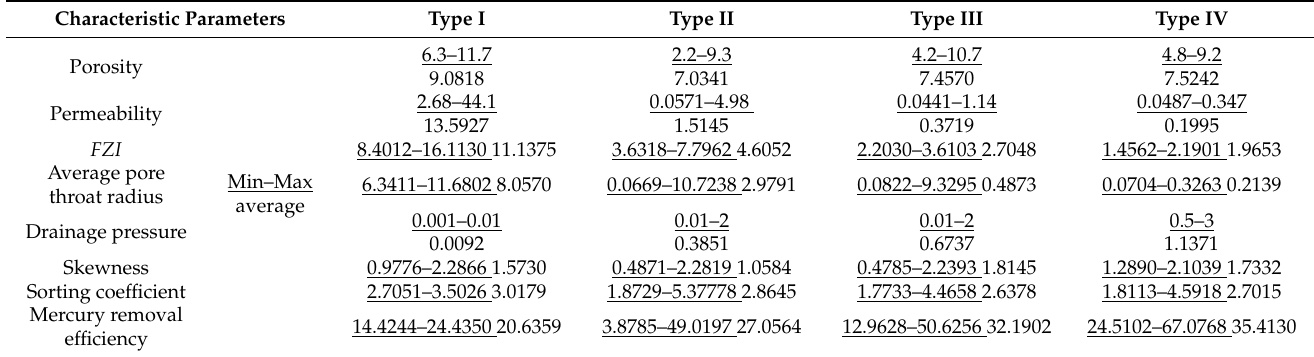
Table 1. The characteristic parameters of pore structure of different types of reservoirs.